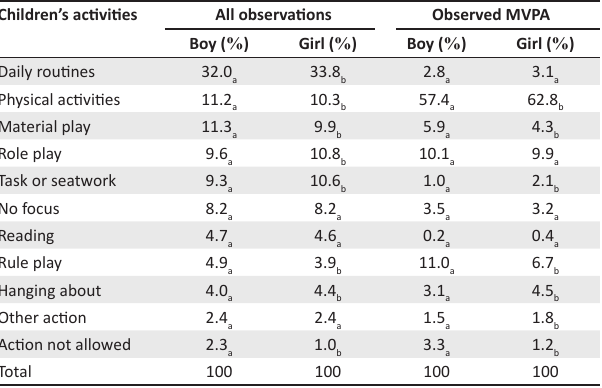
TABLE 3: Proportion of all observations in children’s activities and proportion of moderate-to-vigorous physical activity between genders (boy n = 26 522, girl n = 23 767).